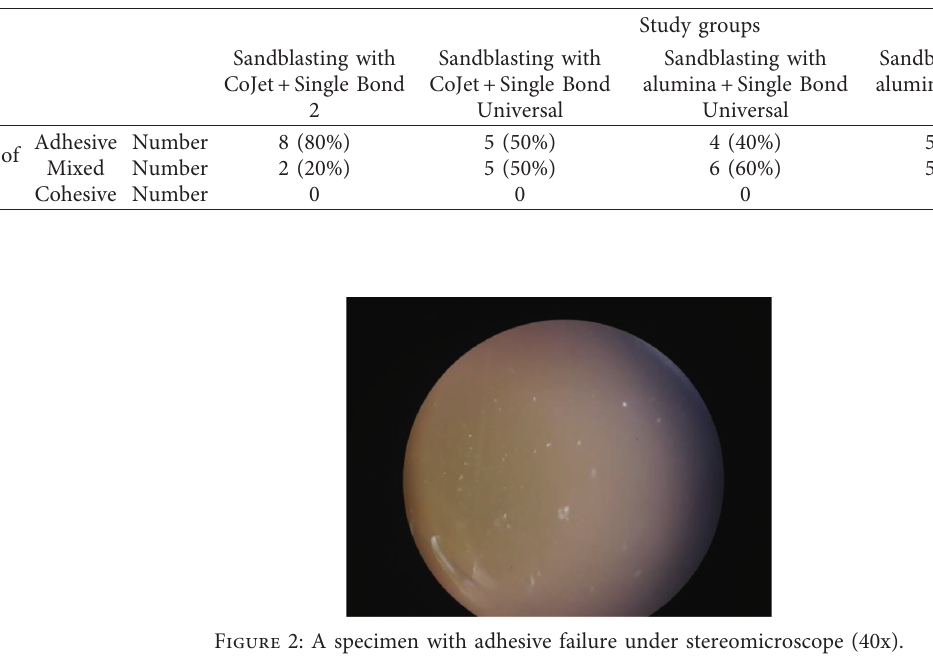
Figure 1: Mean and 95% confidence interval of shear bond strength of the study groups. Table 3: Frequency percentage of modes of failure in the groups.